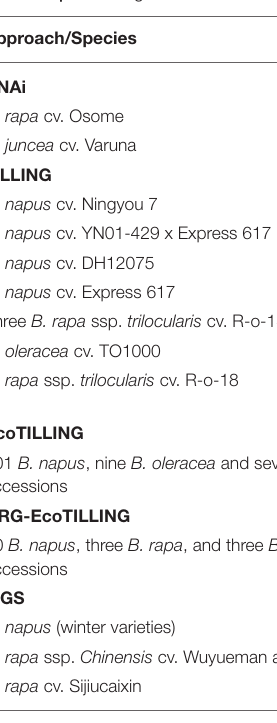
TABLE 4 | Reverse genetic resource in Brassica over the last 10